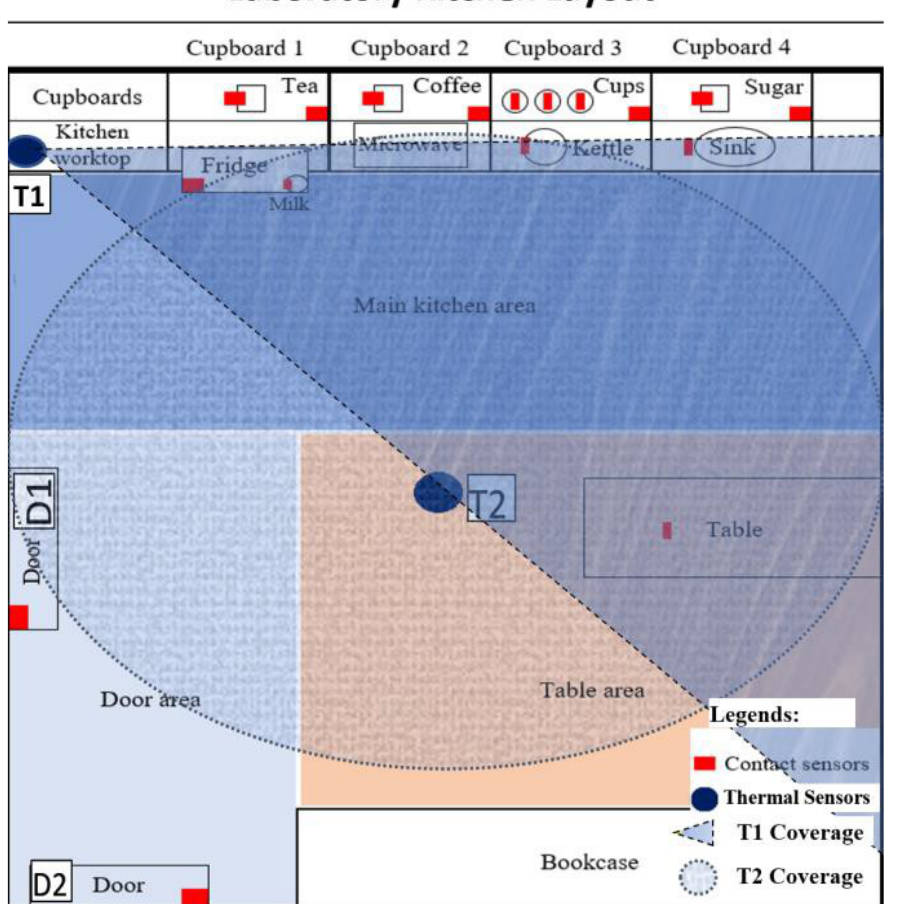
Figure 2. Laboratory kitchen layout. The areas marked in red indicate the location of the contact sensors. Thermal sensors are indicated by the navy-blue oval shape as T1 and T2 for lateral and ceiling thermal sensors, respectively. The coverage of T1 is indicated by the triangular area, while that of T2 is indicated by the oval area. In Figure 2 , the lateral and the ceiling SSs are represented as T1 and T2, respectively. Whilst T 1′ s indicative coverage included half of the kitchen area, as represented by the triangular shades in Figure 2 , T 2′ s coverage included a larger portion of the kitchen area, as indicated by the oval shades. During data acquisition, each participant (at a time) walked